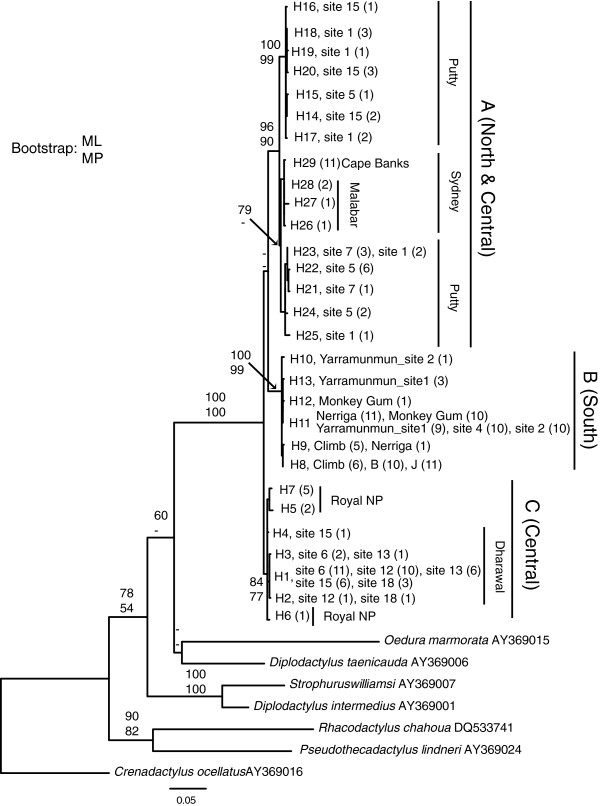
Geographical distribution of the gecko (Oedura lesueurii) tissue samples used for genetic analyses, with mean ϕST values and K2P distance between lineages (A, B, and C).